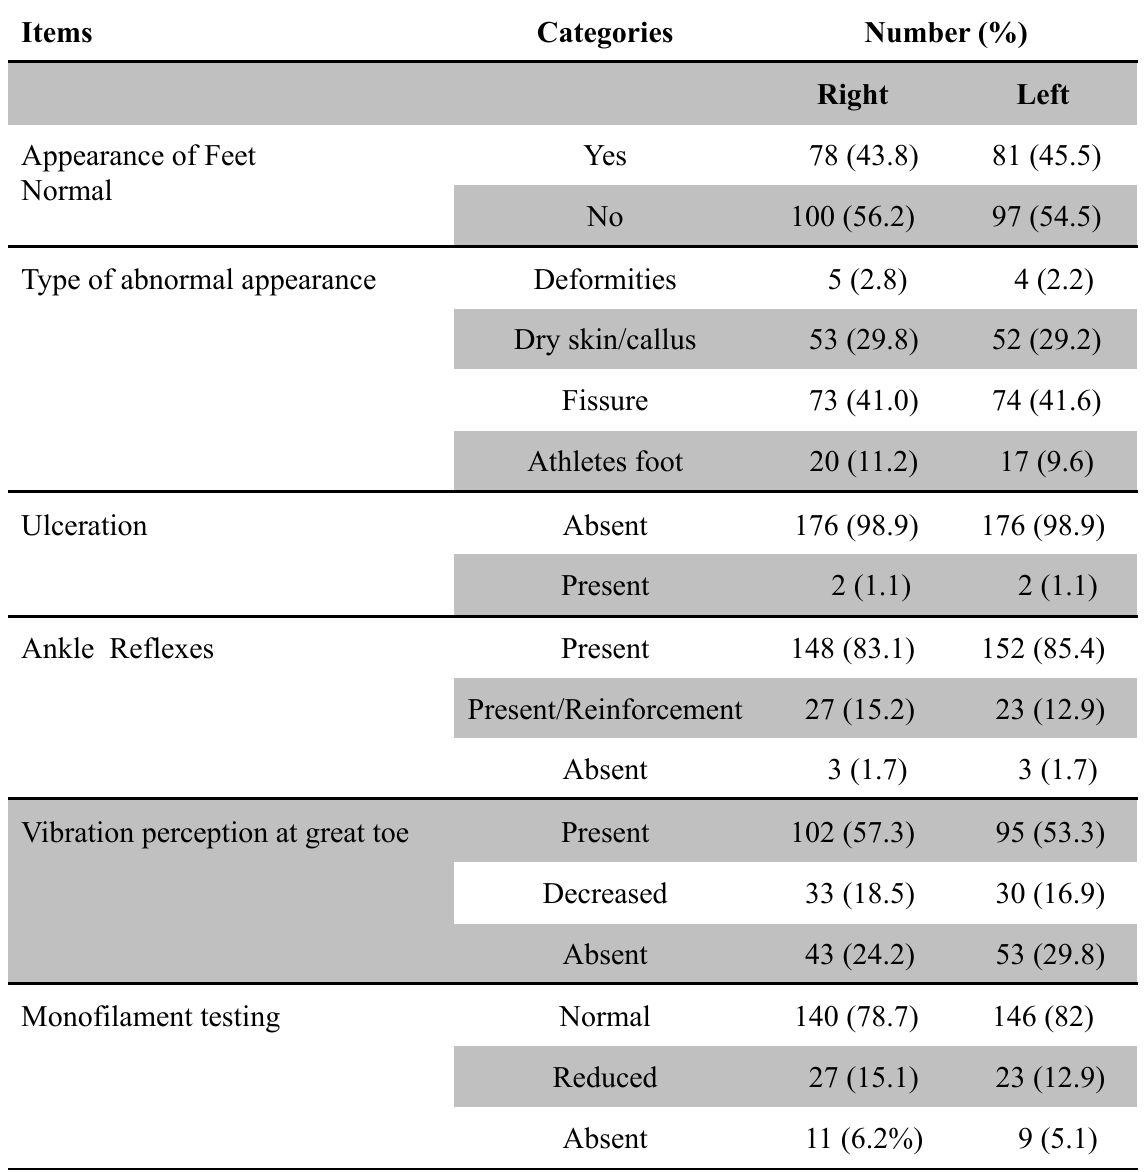
Table 3 Michigan Neuropathy Screening Instrument physical assessment findings of